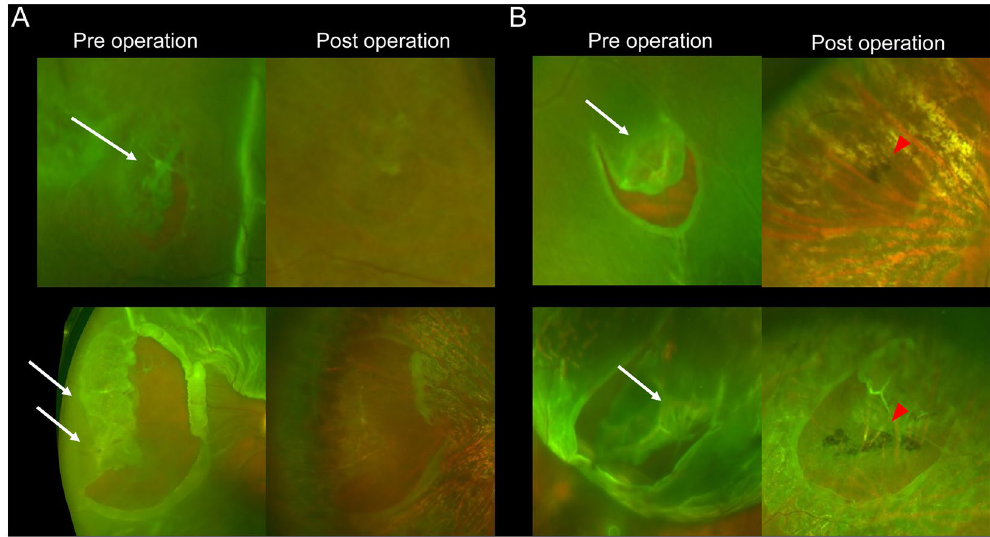
Figure 1. Lattice degeneration (LD) associated with rhegmatogenous retinal detachment (RRD) examined by pre- and postoperative ultra-widefield (UWF) color scanning light ophthalmoscopy (SLO). ( A ) LD without a pigmentary lesion (PL) in two representative cases. ( B ) LD with PL in two representative cases. The preoperative UWF images show the white vessels and retinal thinning within the LD lesions. White arrows indicate LD, and red arrowheads indicate